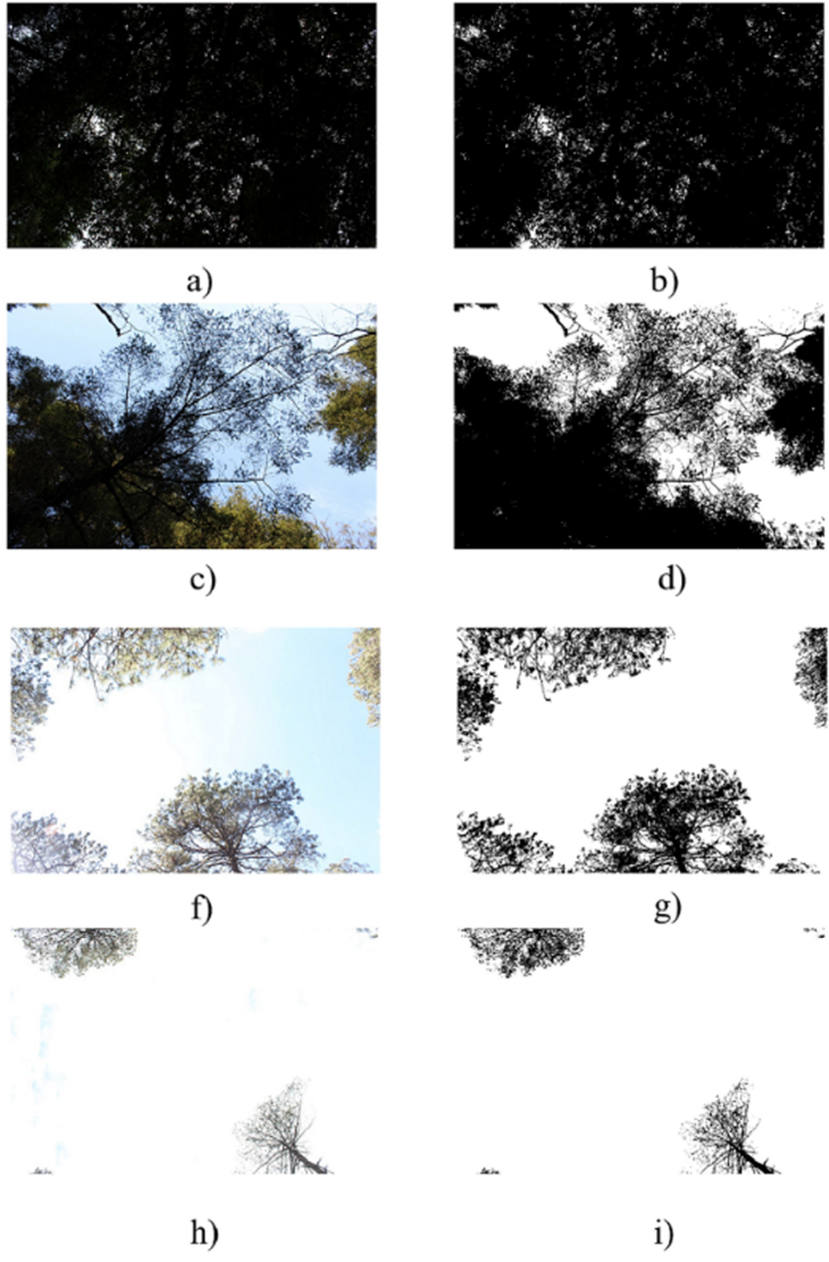
Figure 7. Classification of zenith images, with different cover conditions. Images ( a , c , f,h ) correspond to the original photograph. Images ( b , d , g , i ) correspond to the adaptive threshold classifier.